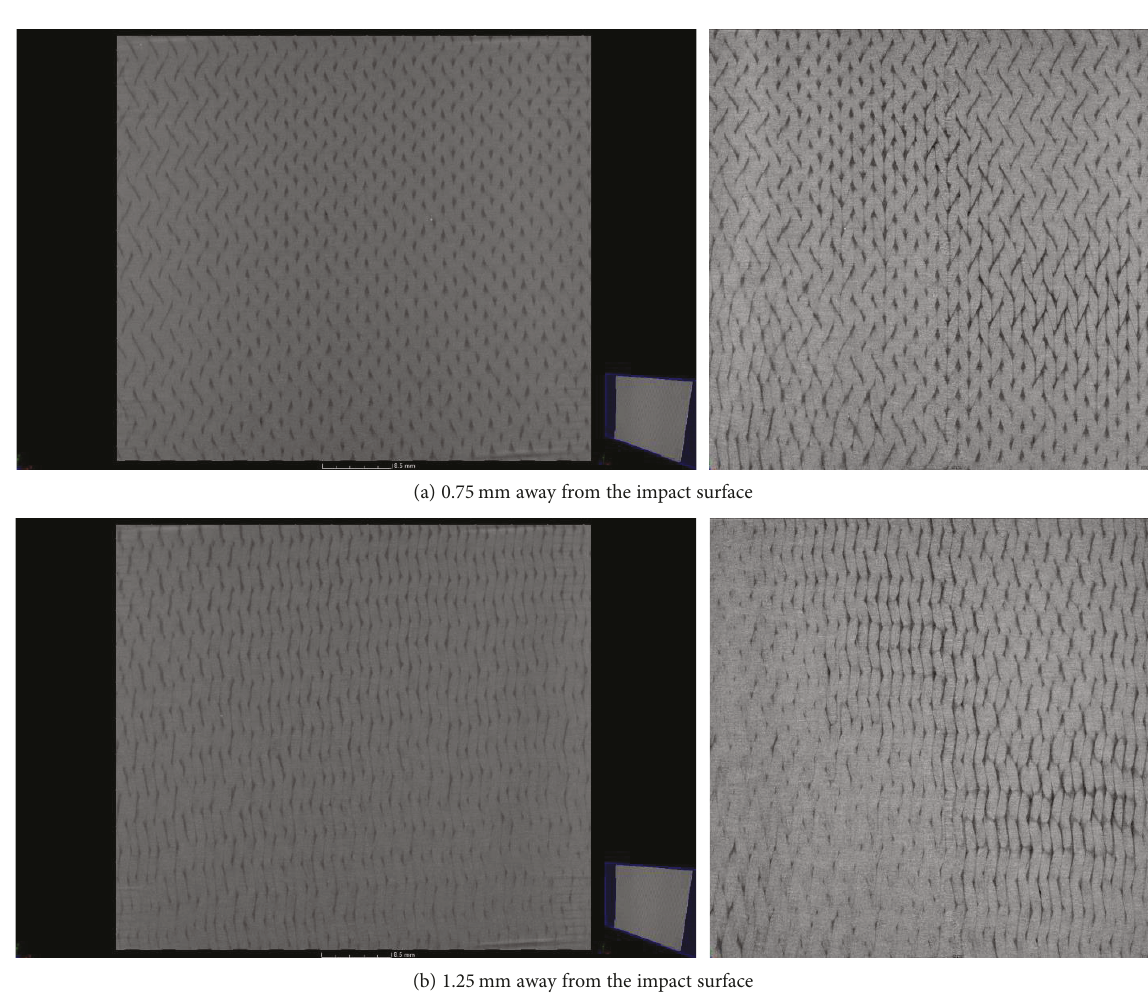
Figure 8: X-ray image of 20 ° braiding composite target in B20-08 test: before impact (left) and after impact